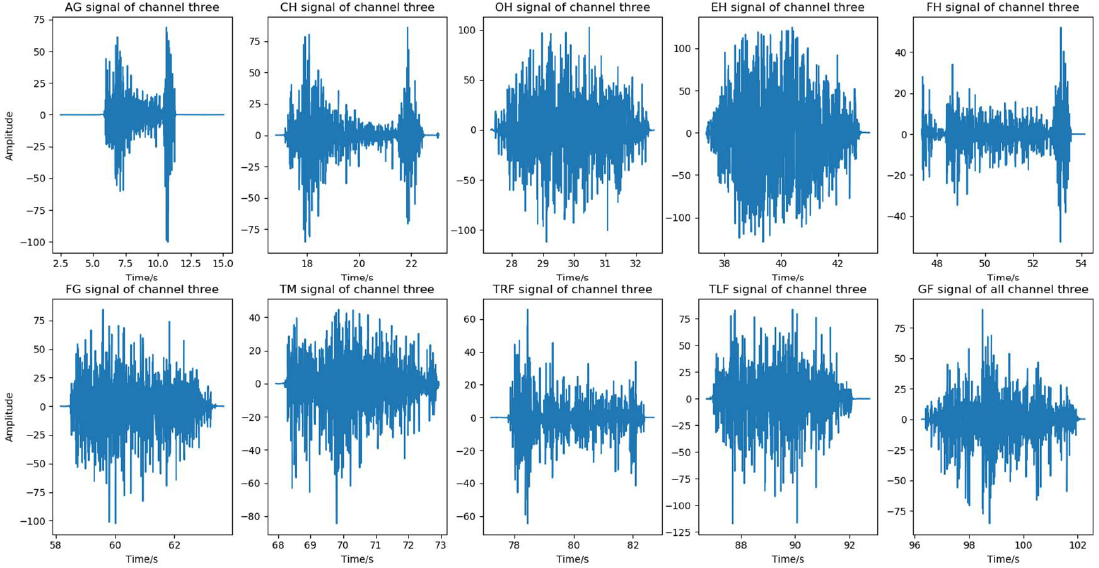
Figure 4. The SEMG signal wave of 10 gestures.